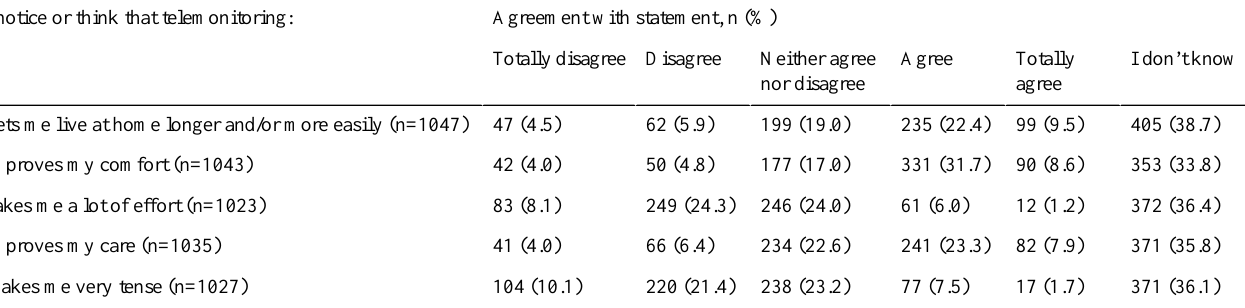
Table 3. Opinions of telemonitoring from patients with chronic diseases (n=1023-1050), 2019.